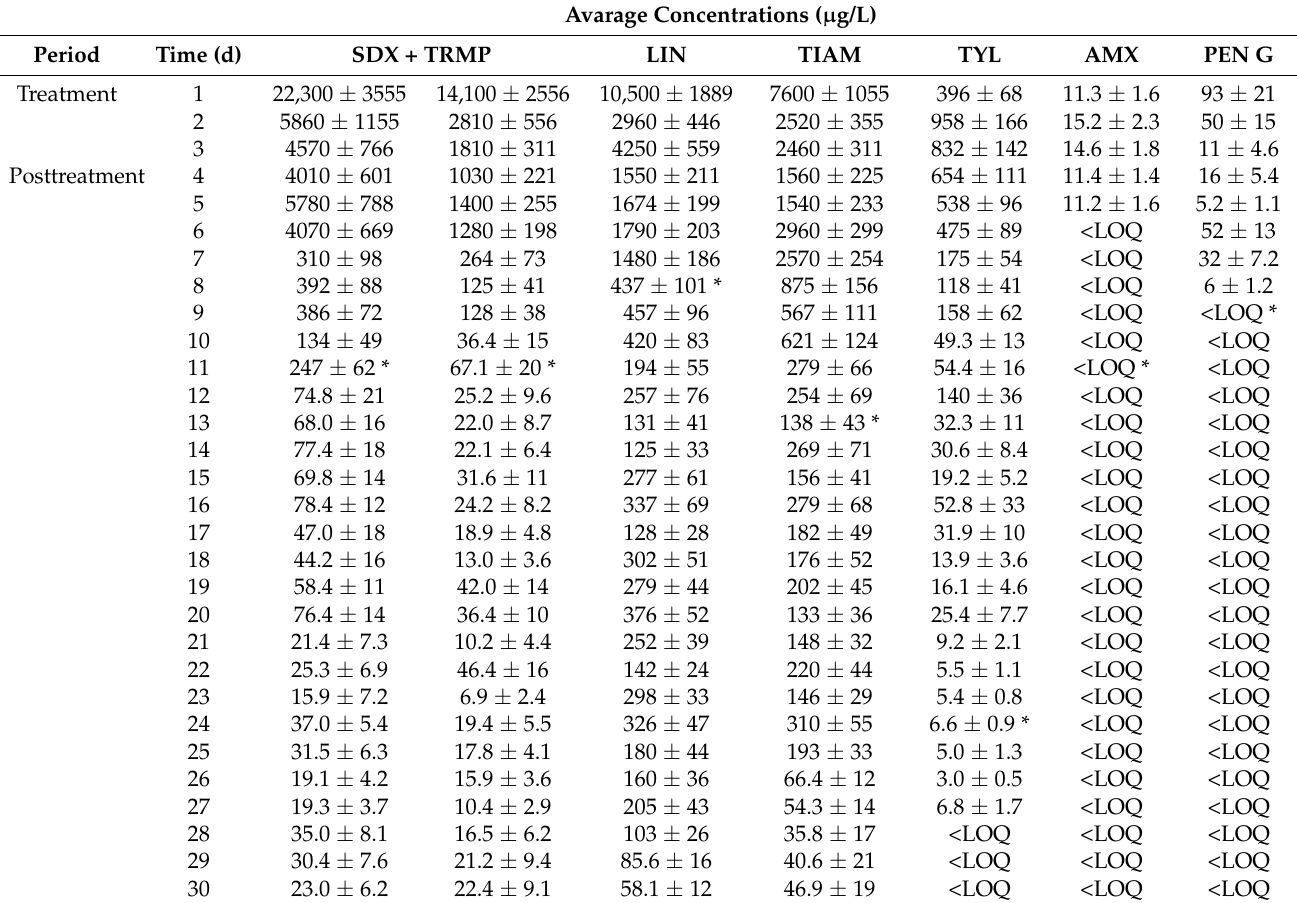
Table 2. Results of oral fluid samples analysis. Avarage Concentrations ( µ